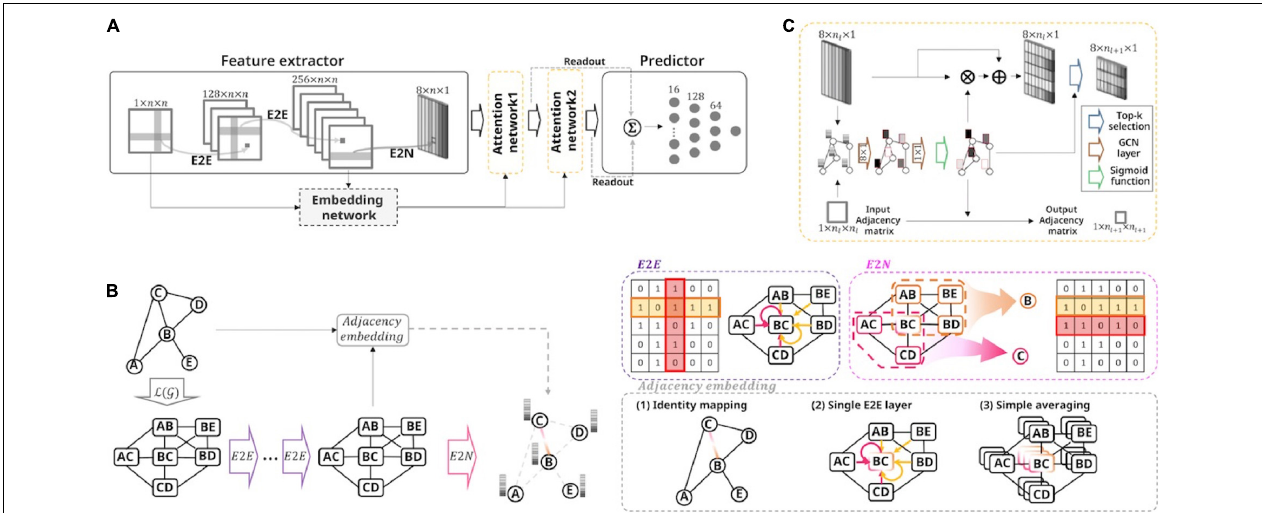
FIGURE 1 | Overall framework of the proposed model and the toy example for the feature extractor. (A) Schematic of the model architecture. This model accepts the brain connectivity matrix as input and predicts the ASD severity score of all subjects. We employed the feature extractor followed by hierarchical self-attention graph pooling layers, embedding network, and fully connected network. The embedding network learned the adjacency embedding, which imposes information about the relationships among extracted node representations of the preceding feature extractor. (B) A toy example of the proposed feature extractor. With a sample graph (consisting of five nodes and five undirected-, and unweighted-edges), a stack of E2E layers embeds the connectivity features over a line graph of the original connectivity matrix. An E2N layer then aggregates the features to extract the node representations. Using input connectivity or embedded connectivity-based features, the embedding network define the adjacency matrix. There are three variants with the embedding layer: Identity, single E2E, and averaging method. (C) The self-attention graph pooling layer accepts the node-level features and embedded adjacency as input and learns a sparse graph representation. The GCN layers calculate the self-attention scores and then the scores were used to select the top k nodes. After selecting the nodes, the attention mechanism was performed using the survived nodes.